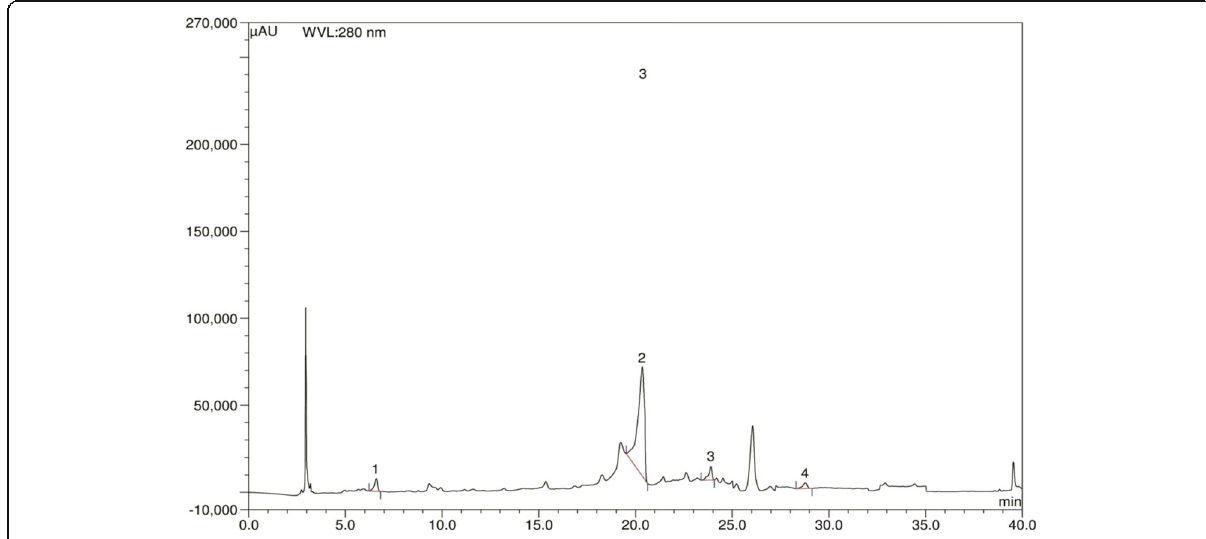
Fig. 2 HPLC chromatogram of leaf extract. (Peaks: 1: gallic acid; 2: vanillic acid; 3: vanillin; 4: ellagic acid)